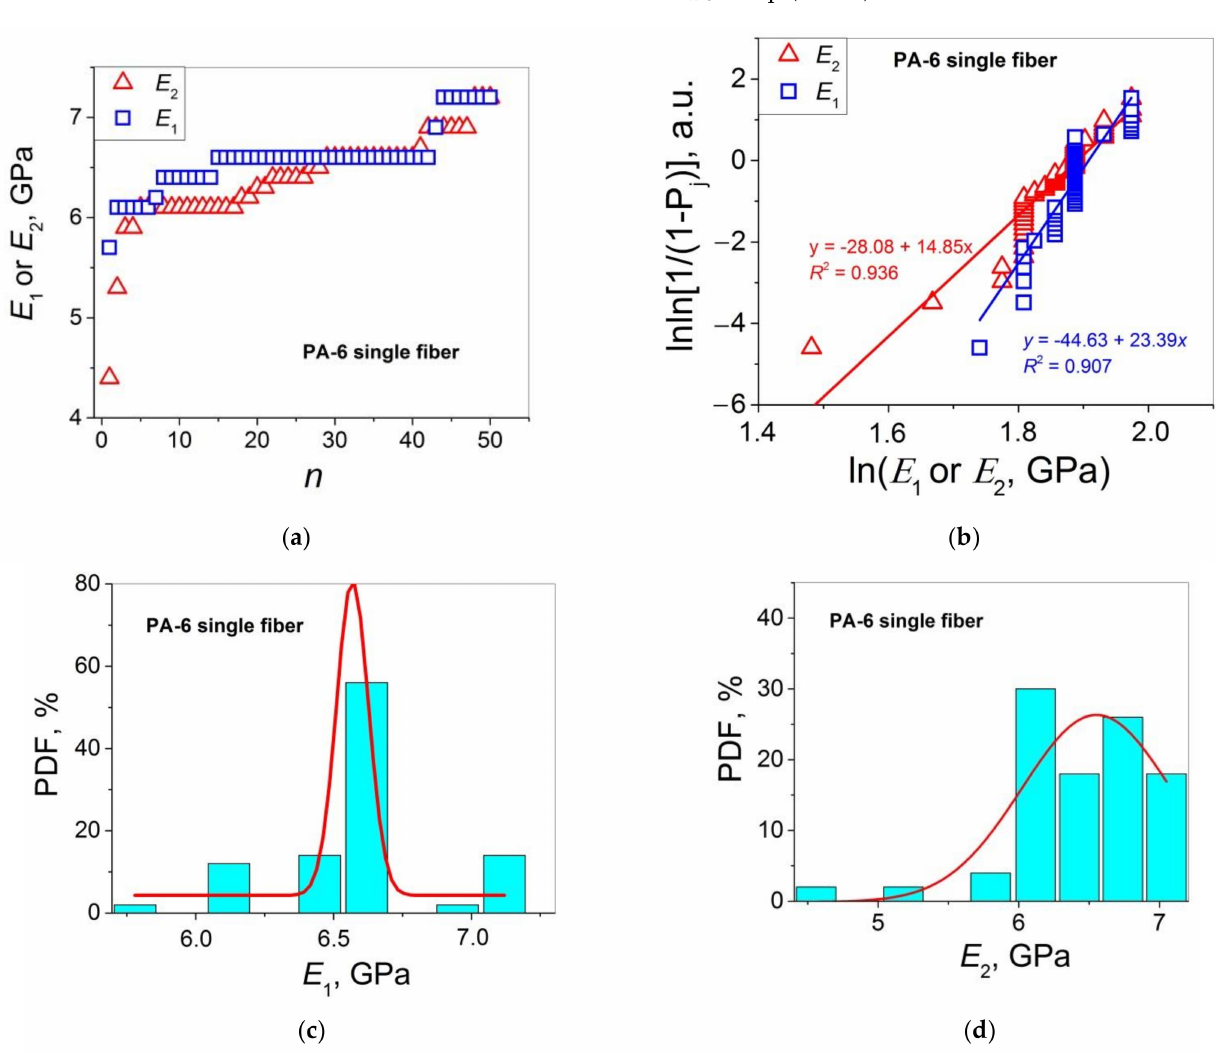
Figure 3. ( a ) Moduli E 1 and E 2 as functions of sample number n in an ascending order for PA 6 single fibers; ( b ) Weibull’s plots for the data presented in ( a ); PDF vs. E 1 ( c ) and E 2 ( d ) for the data presented in ( a ); the bell curves are the Gaussian fitting